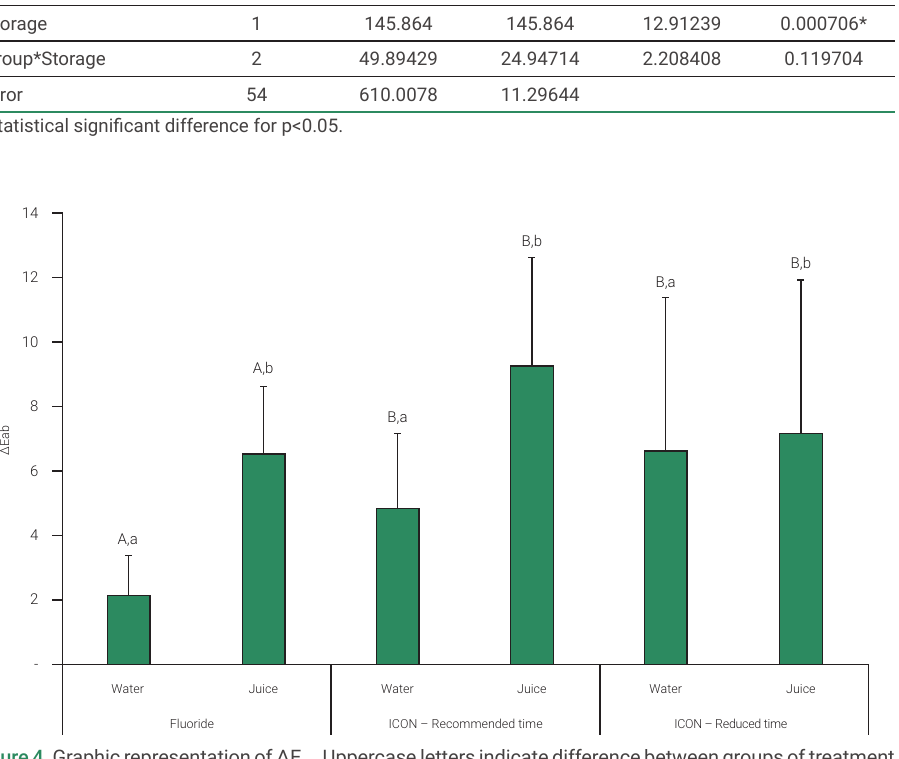
Figure 4. Graphic representation of ∆E . Uppercase letters indicate difference between groups of treatment ab (fluoride, ICON – Recommended time and ICON – Reduced time) and lowercase letters indicate difference between storage methods (water and